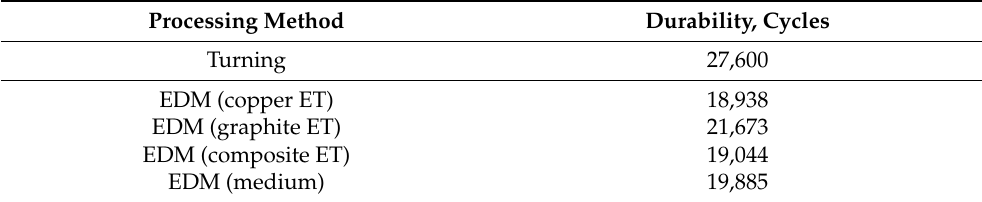
Table 9. Study of the durability of specimens from steel 15 at low-cycle